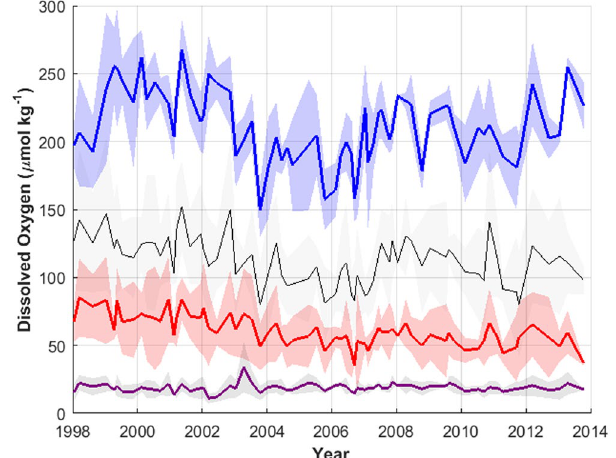
Figure 4. Line 67 mean dissolved oxygen concentrations along σ θ 25.5 kg m − 3 (blue), 26.3 kg m − 3 (black), 26.7 kg m − 3 (red), 27.0 kg m − 3 (purple) from 1998 to 2013. Shaded regions represent two standard deviations from the